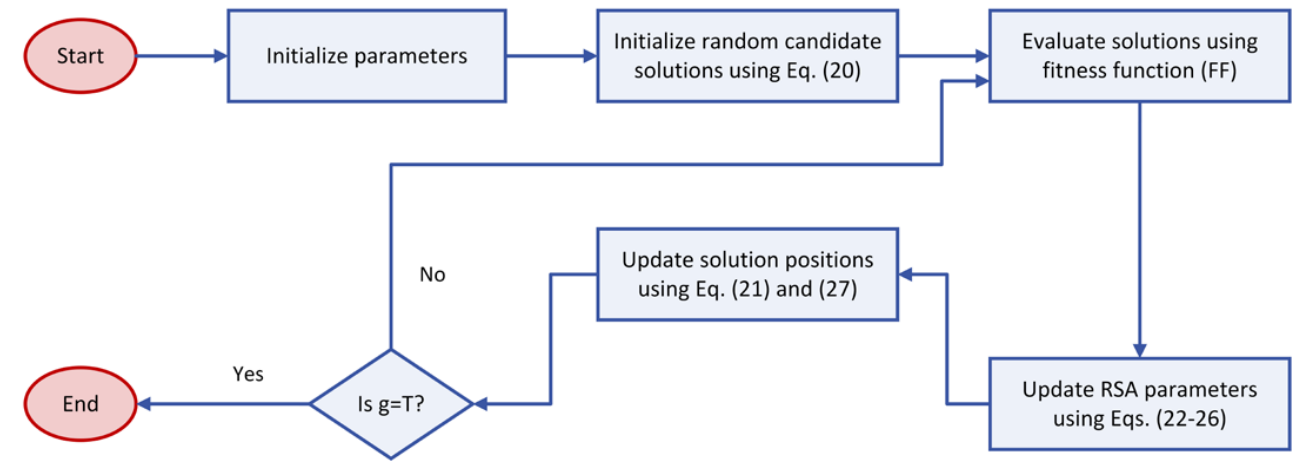
Figure 4. RSA algorithm’s flow chart.